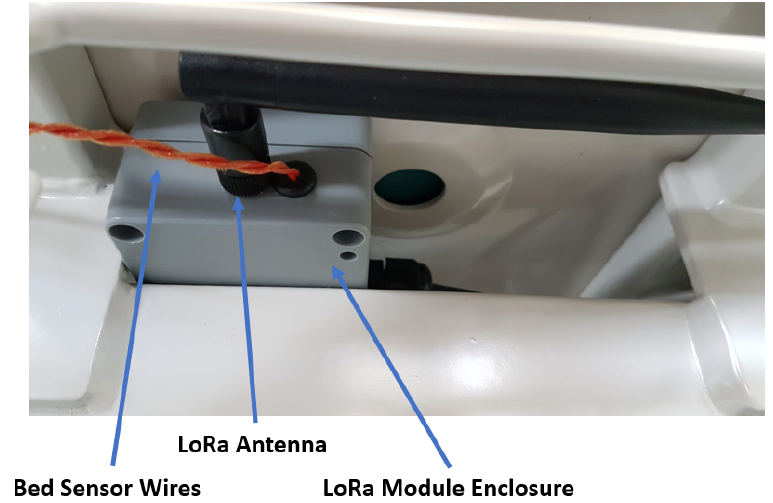
Figure 1. Photograph of wireless LoRaWAN